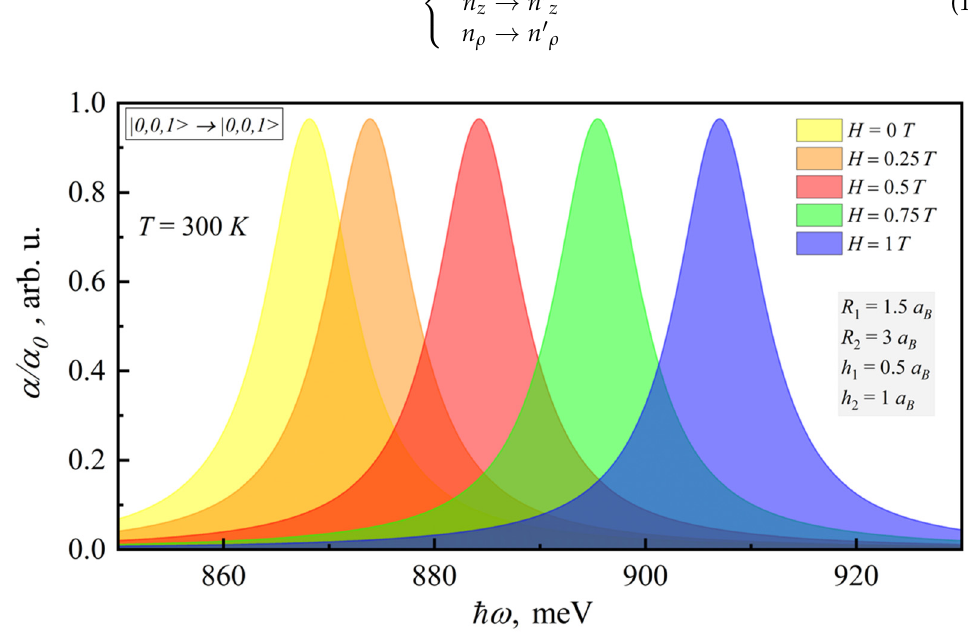
Figure 2. Dependence of the room-temperature interband absorption coefficient on the photonenergy for different magnetic fields.